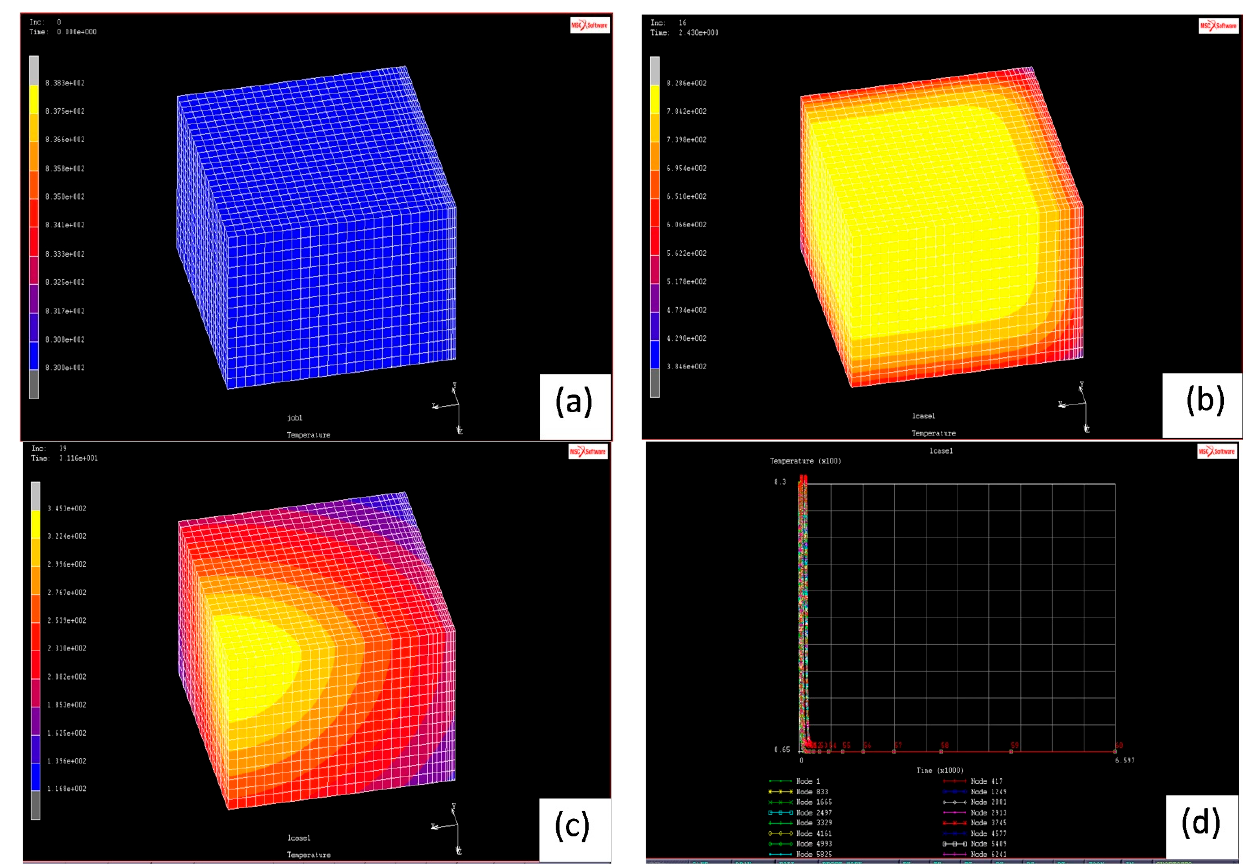
Figure 5. Temperature field cloud picture and cooling curve of nodes. ( a ) t = 0 s, ( b ) t = 2.43 s, ( c ) t = 31.16 s, and ( d ) cooling curve.